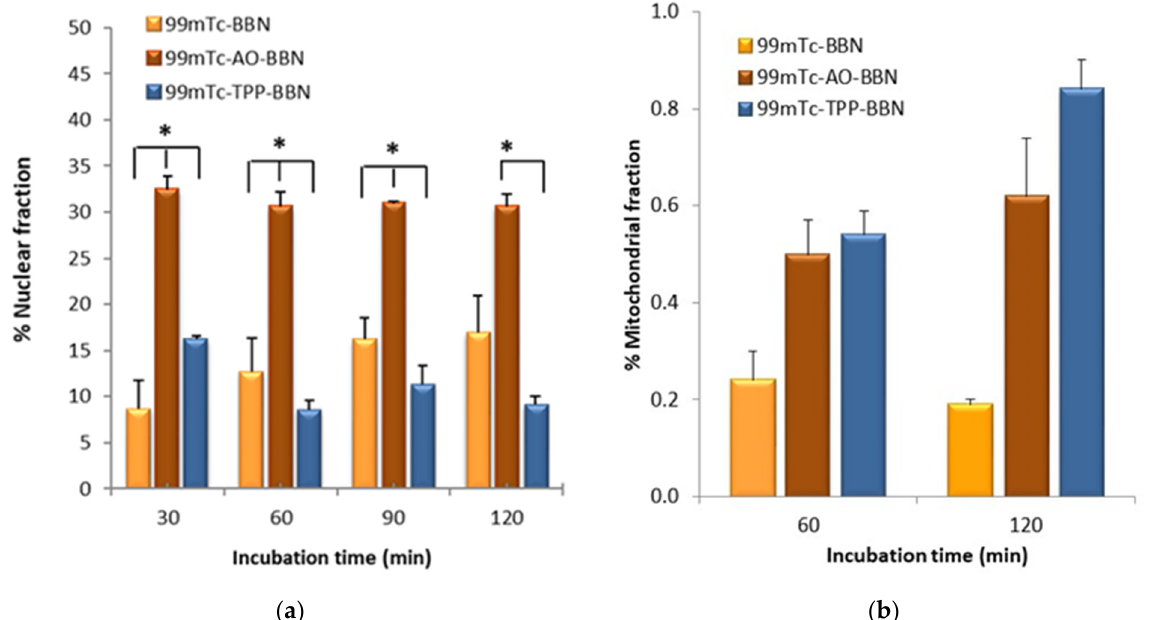
Figure 4. Nuclear uptake ( a ) and mitochondrial uptake ( b ) of 99m Tc-BBN , 99m Tc-AO-BBN and 99m Tc- TPP-BBN in PC3 cells at 37 °C expressed as a percentage of the cell-associated activity (* p < 0.05).